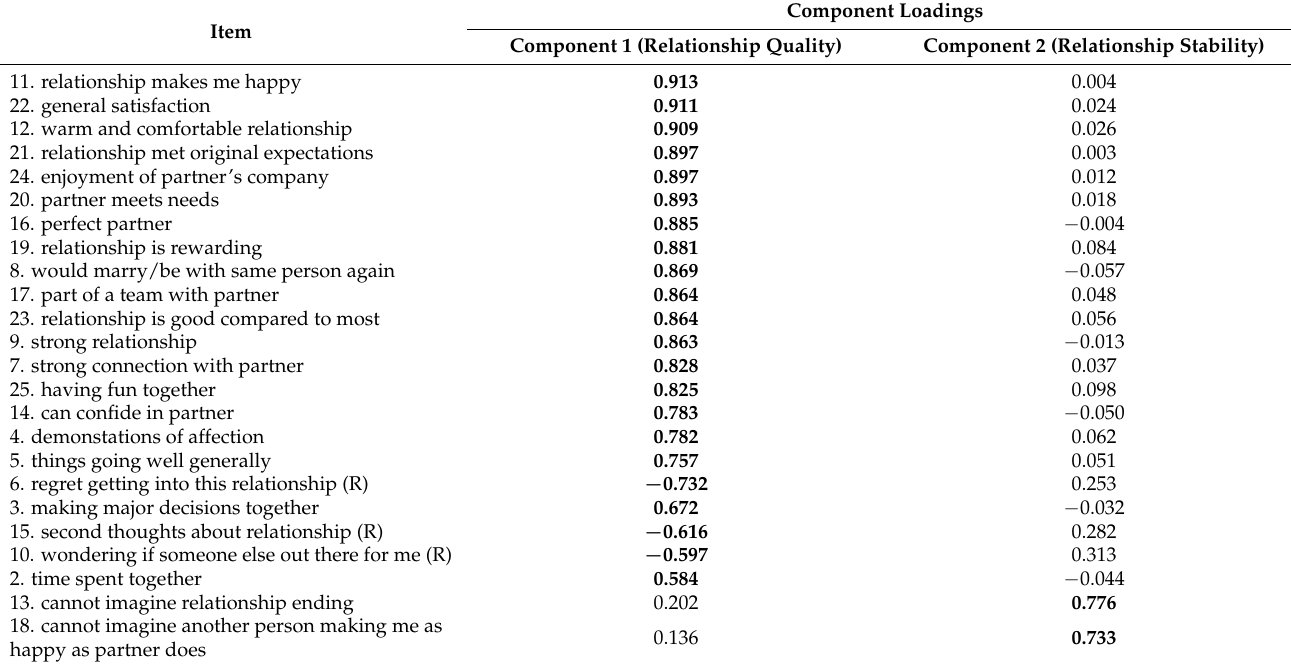
Table 5. Principal component analysis of relationship satisfaction.